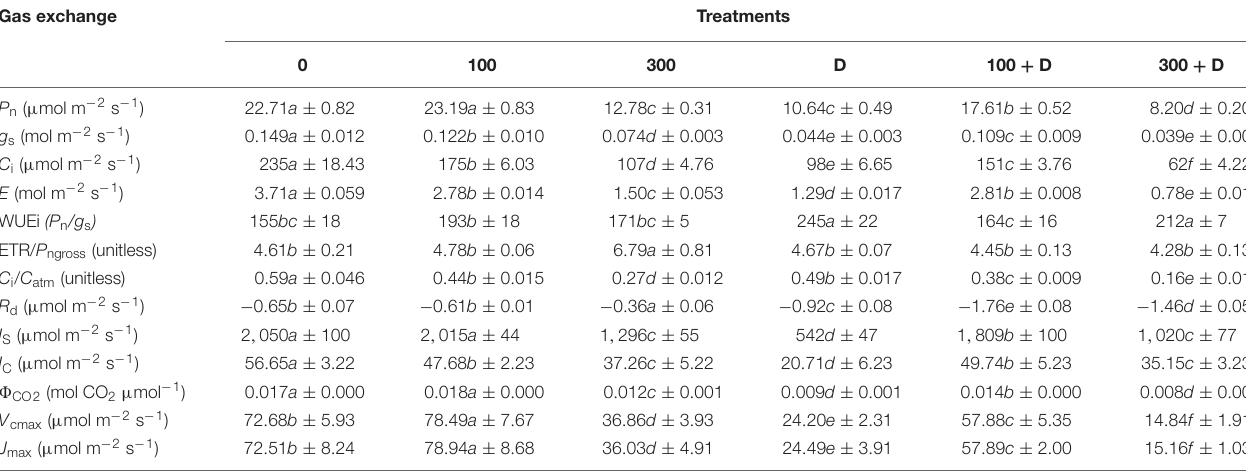
TABLE 1 | CO 2 /H 2 O gas exchange responses under salinity, drought, and the combination of both. Gas